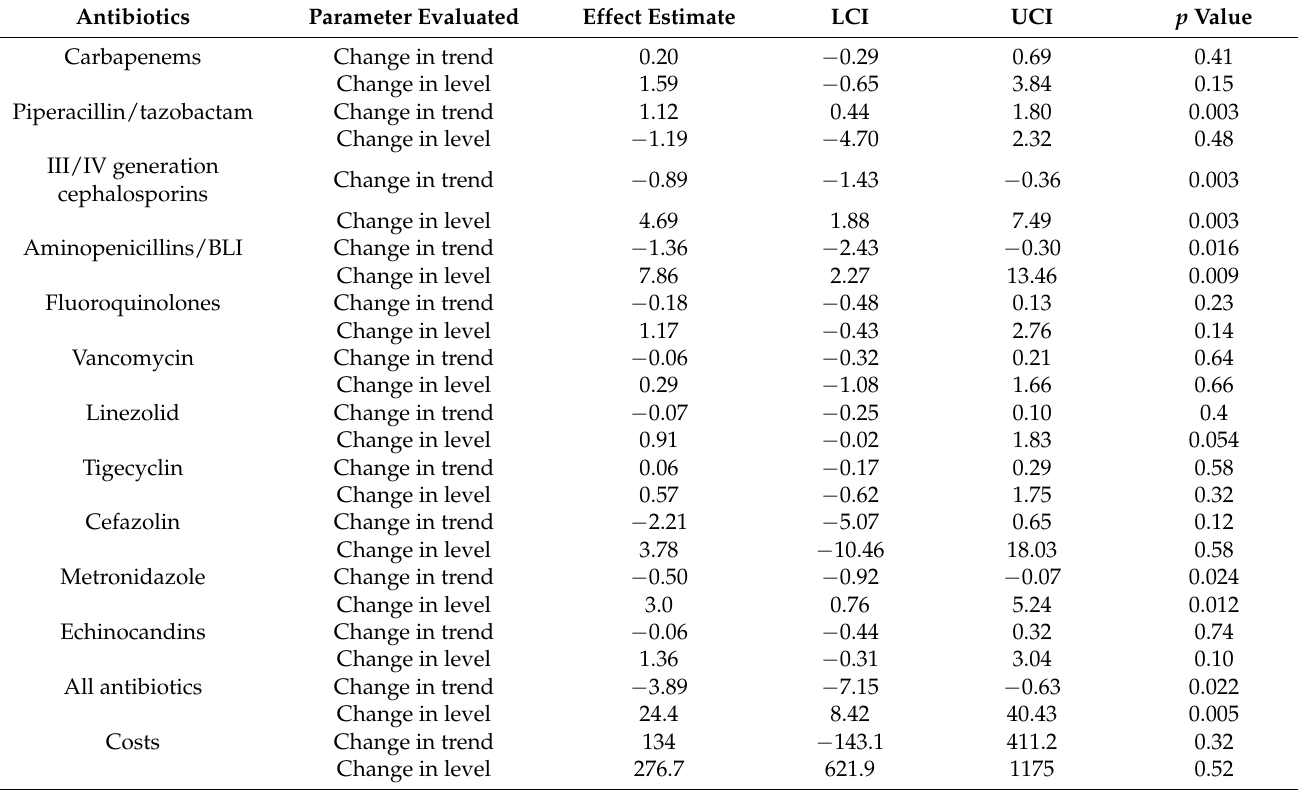
Table 2. Effect of the ASP interruption during COVID-19 pandemic on antibiotic consumption in the 4 surgical units included in the